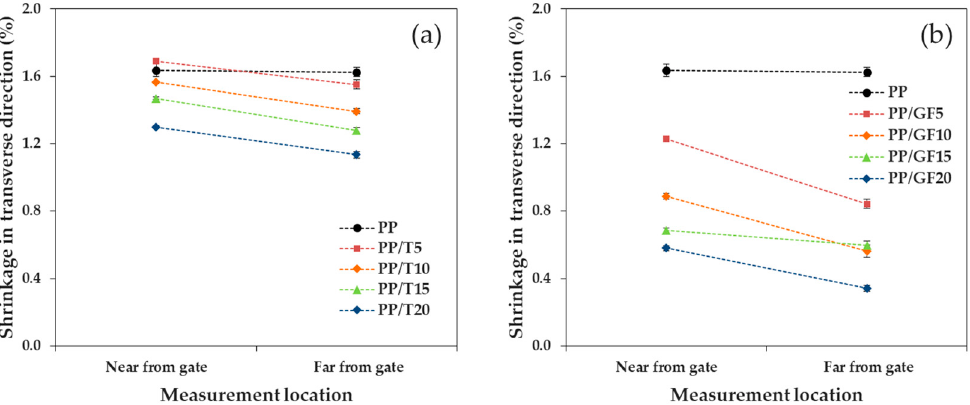
Figure 10. Shrinkage in the transverse direction, as a function of the measurement location: ( a ) PP/T and ( b ) PP/GF.